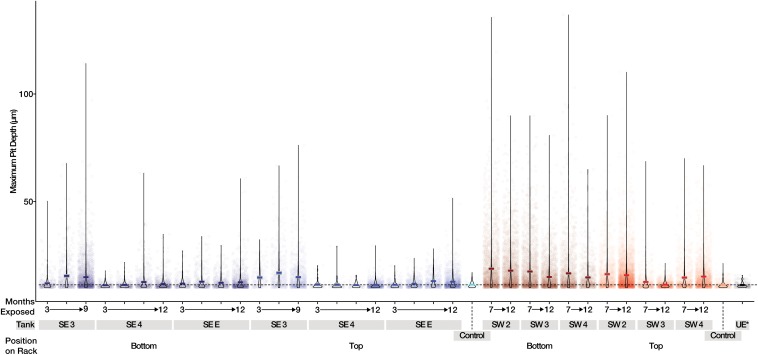
Maximum pit depth measured for uncoated steel witness coupons from SE (Blue) and SW (Red). Mean values are shown as a dark line for each sample. The dashed line represents the mean of witness coupons not exposed to fuel or field conditions.